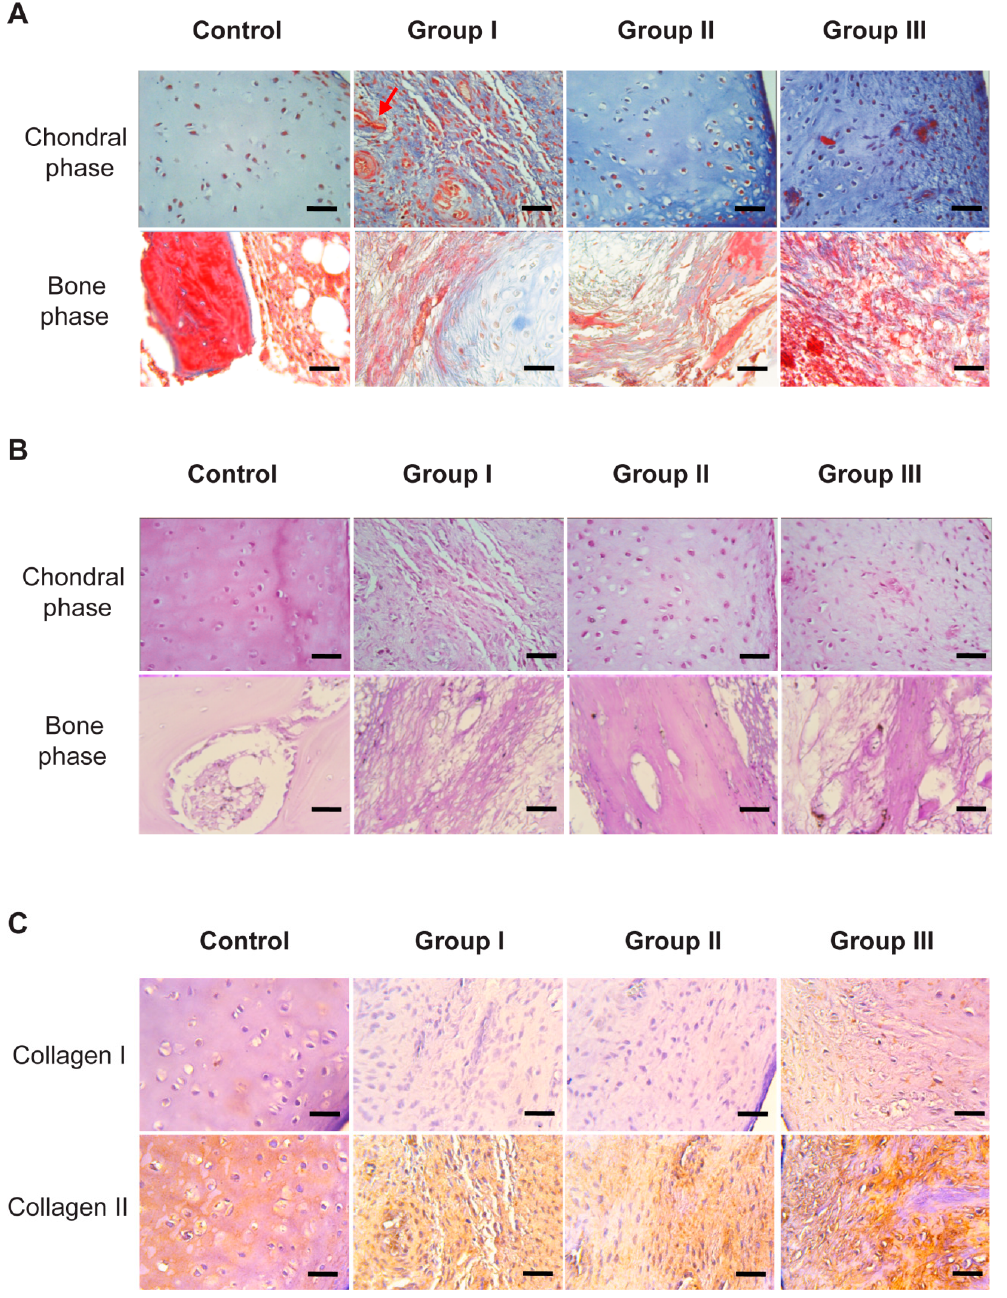
Figure 7. Analysis of repaired tissue at 8 weeks post-transplantation. ( A ) Masson’s trichrome staining; the scaffold of Group II shows a greater organization of collagen fibers. In the chondral phase, the control group is observed with pale staining in the territorial and interterritorial matrices between the chondrocytes. Groups I, II and III have collagen bundles and cells between them, and a greater organization is observed in group II. The presence of blood vessels is indicated by red arrows. In the bone phase, a better organization of the trabeculae in Group II is observed. Scale bar = 50 µm. ( B ) PAS staining; The Group II scaffold induces a greater secretion of complex polysaccharides at the implant site. All the groups show a positive reaction to the histochemistry of PAS; however, it is weaker in the chondral phase of Group I. There is a greater organization of bone tissue in Group II, unlike Groups I and III. Scale bar = 50 µm.( C ) IHC with anti-collagen I and II; the scaffolding of Group II induces a greater organization of collagen II at the implant site. Chondral phase: a higher content of collagen II than type I was observed in all the experimental groups, similar to the control group. Group II shows a better organization of the fibers in the extracellular matrix. Scale bar = 50 µ